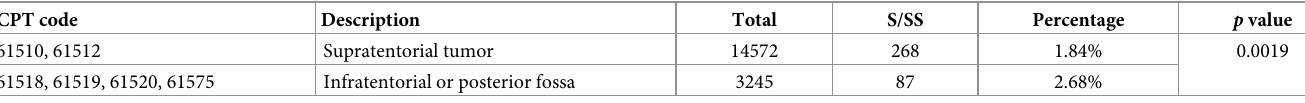
Table 4. Incidence of S/SS based on location in the brain.